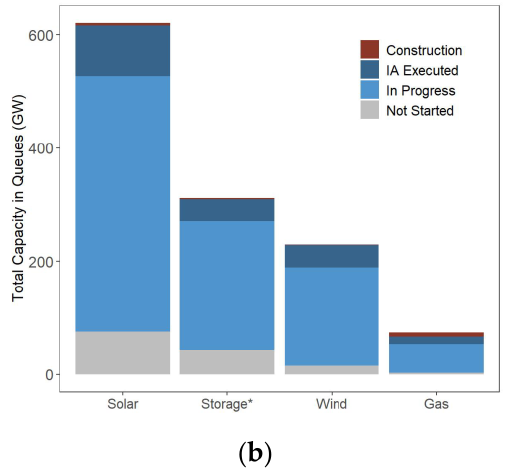
Figure 2. Interconnection queues for capacity generation from different energy sources. ( a ) Expected yearly distribution for capacity to become online. * Also includes co-located/hybrid storage capacity for some projects. ( b ) Total capacity in different stages of queues as of 2021 where IA = interconnection agreement